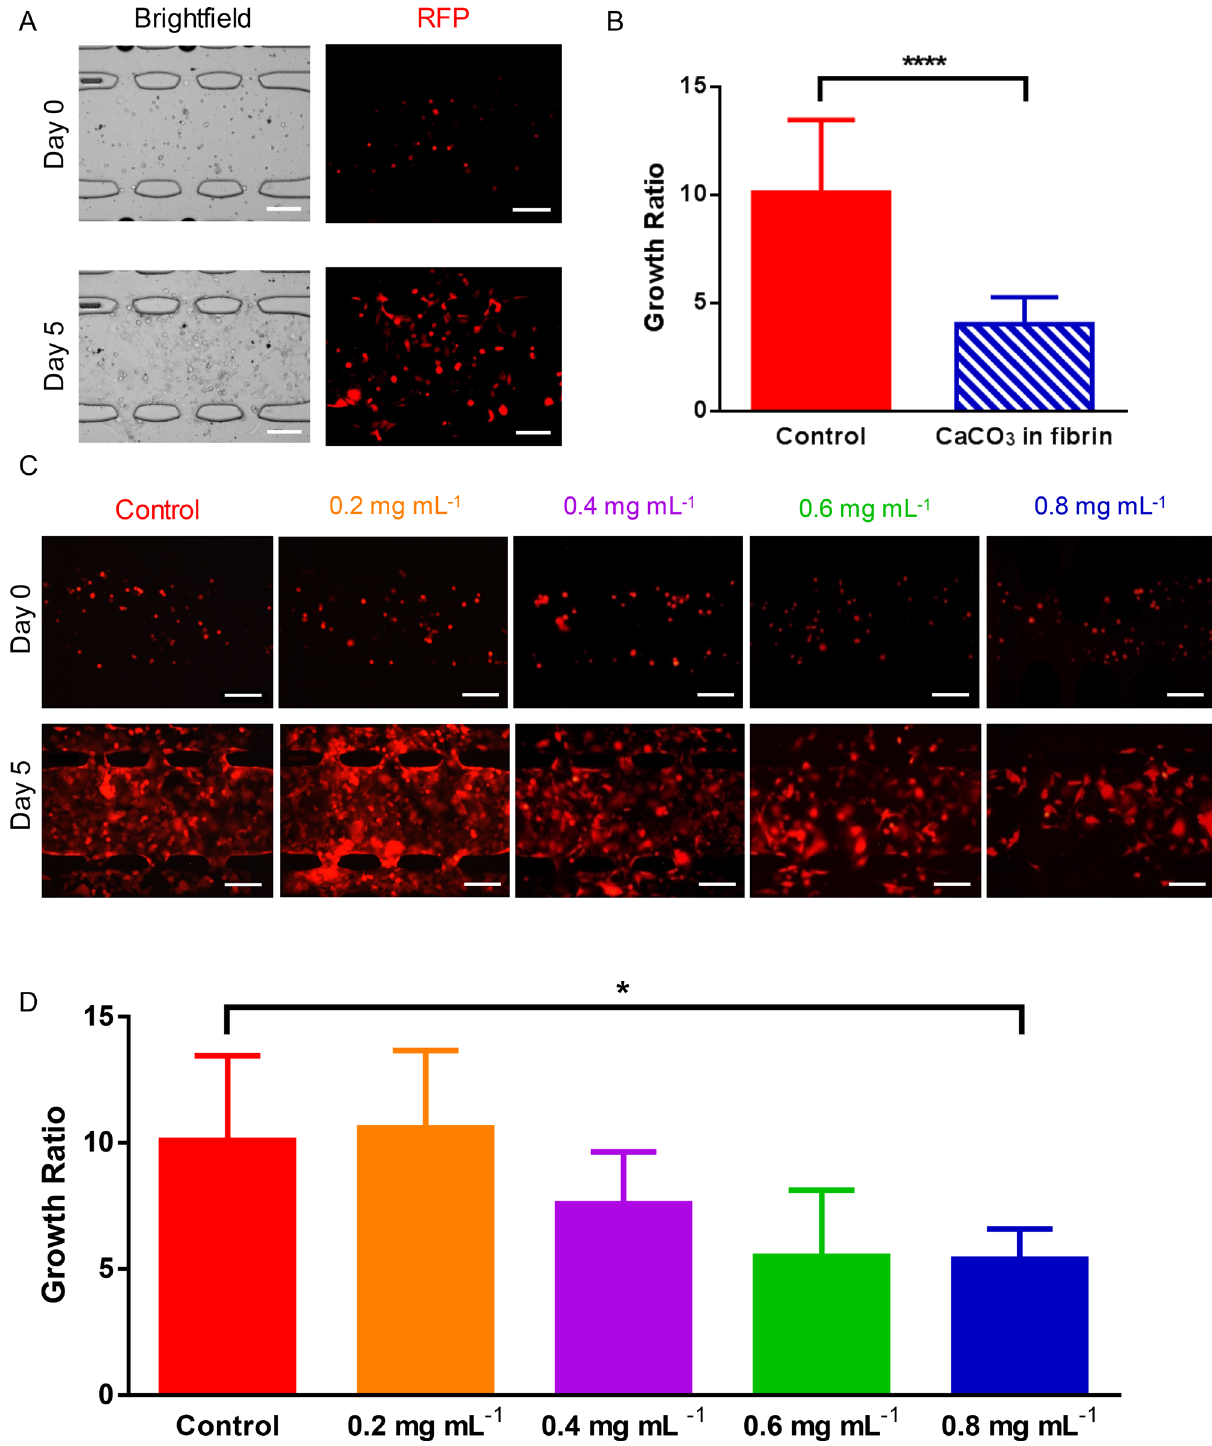
Figure 3. Nano CaCO 3 effects on MDA-MB-231 cell growth. ( A ) Representative images of the MDA-MB-231 cells loaded in fibrin gels. Images of the start (top) and end (bottom) of the experiment with fibrin gels containing 1.6 mg mL −1 concentration of CaCO 3 nanoparticles is shown. Scale bar = 200 µm. ( B ) Embedding CaCO 3 nanoparticles inside fibrin. After embedding CaCO 3 nanoparticles inside our fibrin gel, the quantification of tumor growth showed significantly more growth under the control conditions. **** p < 0.0001. ( C ) Representative images of MDA-MB-231 cells expressing RFP grown in varying concentrations of CaCO 3 nanoparticles. Images of the tissue chambers right after loading are shown in the top row, and images at the end of the experiment are shown in the bottom row. Scale bar = 200 µm. ( D ) Quantification of the effects of CaCO 3 nanoparticles at varying concentrations. At 0.8 mg mL −1 , tumor growth was significantly inhibited compared to the control condition. * p <